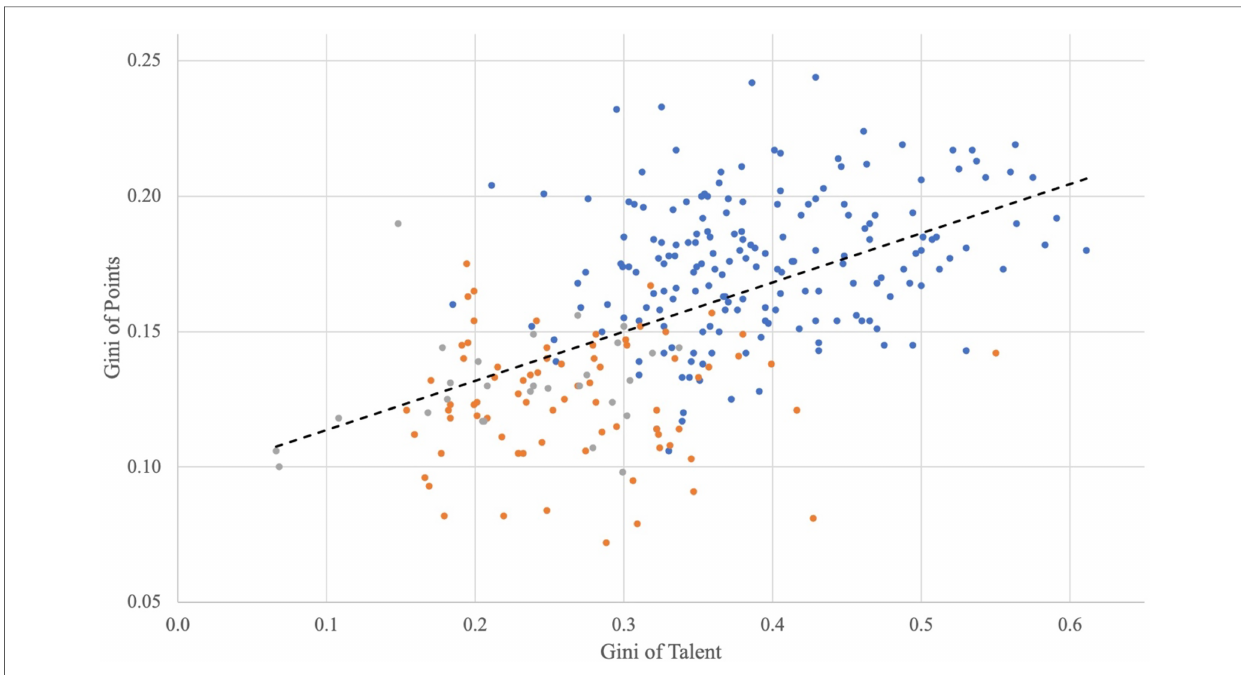
FIGURE 5 Talent and points concentration.